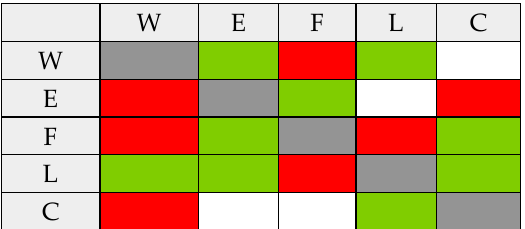
Figure 4. Schematic representation of interlinkages among all five nexus components. Green represents a “weak” interlinkage, red represents a “strong” interlinkage and white stands for “negligible” interlinkages. Influencing nexus components are shown in the columns and influenced nexus components are shown in the rows. W = Water; E = Energy; F = Food; L = Land Use; C = Climate.